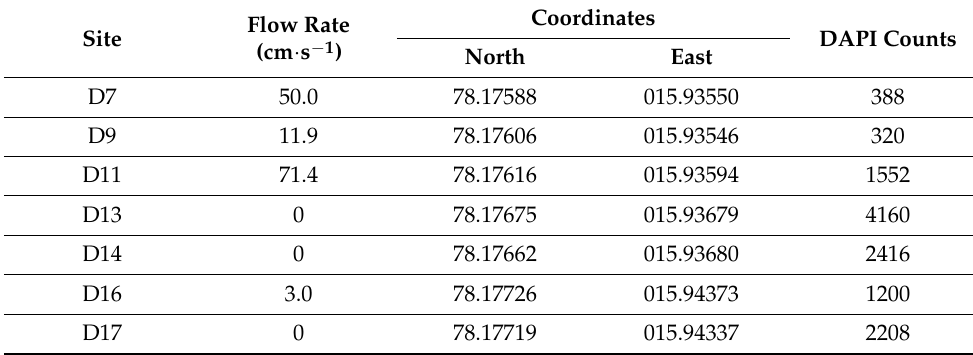
Table 2. Total relative DAPI counts.